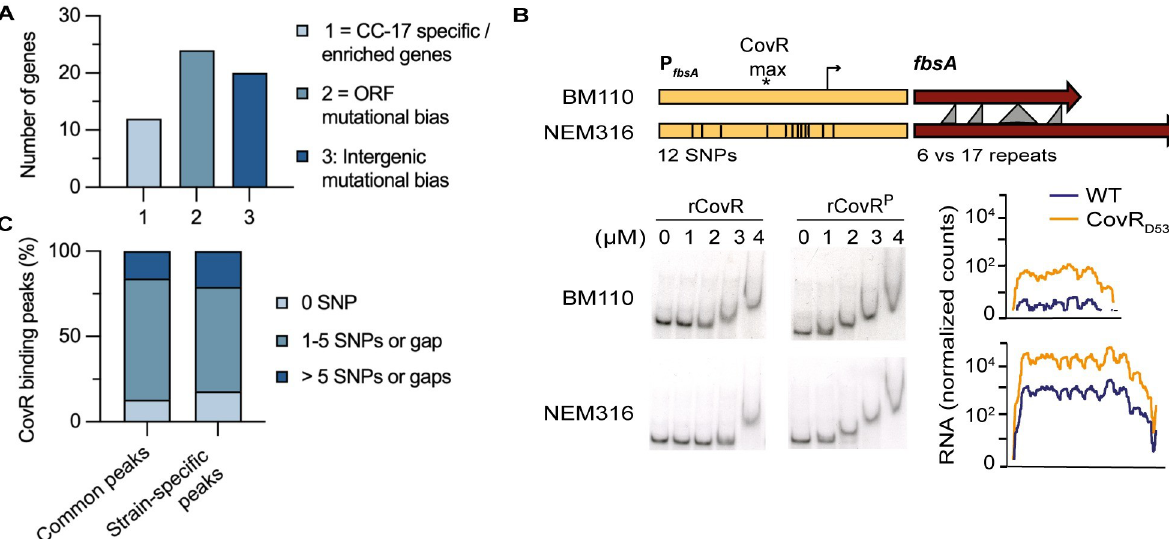
Fig 4. Adaptation of CovR signaling in the hypervirulent lineage. (A) Histogram reporting the number of CovR binding loci on the BM110 chromosome associated with CC-17 specific or enriched genes (category 1), with genes showing a mutational biases indicative of adaptive evolution (category 2), and in intergenic regions with mutational biases suggestive of CovR rewiring in CC-17 (category 3). The ORFs and intergenic mutational biases in the whole GBS population have been previously calculated to reconstitute the evolution of the CC-17 hypervirulent lineage [4] and the detailed list with gene IDs is in S4 Table. (B) CovR regulation of the FbsA adhesin encoding gene in BM110 (CC-17) and NEM316 (CC-23) strains. Schematic representation of the fbsA gene (dark red) and promoter (yellow) in the two strains showing the gene length difference leading to the translation of a protein with a different number of a repeated motif, and the 12 SNPs in the promoter region (336bp). Bottom: binding of non- phosphorylated and phosphorylated rCovR to the two promoters by EMSA and normalized RNA-seq data for the two WT strains and their corresponding CovR D53A mutants. Note that the two strains differ by their basal level of fbsA transcription and not by CovR binding or regulation. (C) Promoters mutations in direct CovR regulated genes. Cumulative percentage of CovR binding loci (250 bp centered on the maximum ChIP-seq signal) with 0 (black), up to five (grey) or more than five SNPs or gaps (white) between BM110 and NEM316 sequences. Common peaks = CovR binding loci detected in BM110 and NEM316; Strain-specific peaks = CovR binding loci detected in one strain only. Sequences alignment was performed by